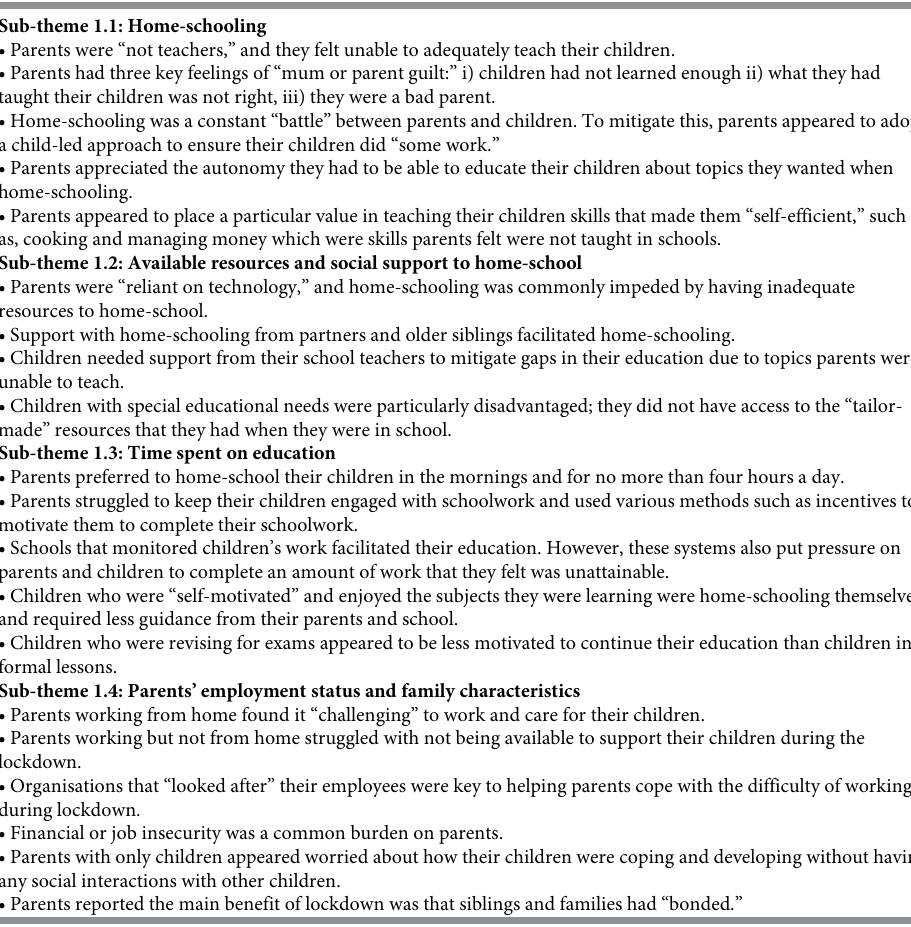
Table 2. The factors that affected how families coped with the COVID-19 school closures and lockdown measures in relation to Theme 1: Families’ dynamics, circumstances, and resources. Theme 1: Families’ dynamics, circumstances, and